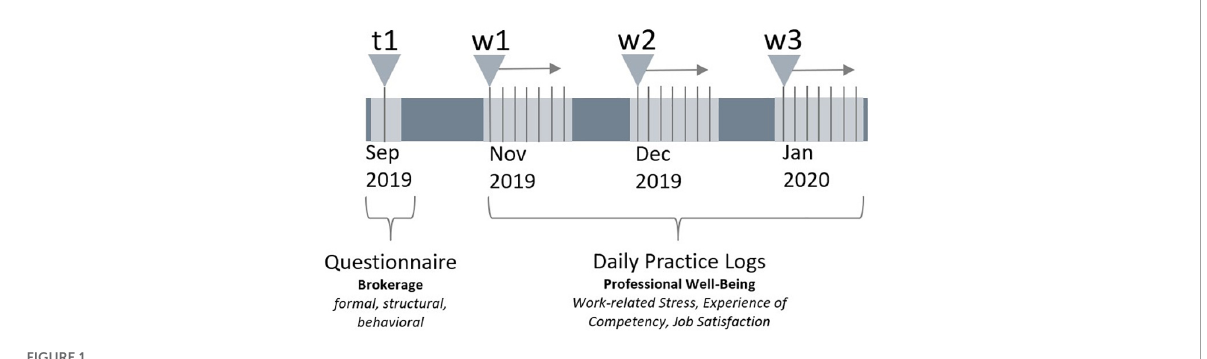
iteratively conducted analyses to establish configural, weak, and strong